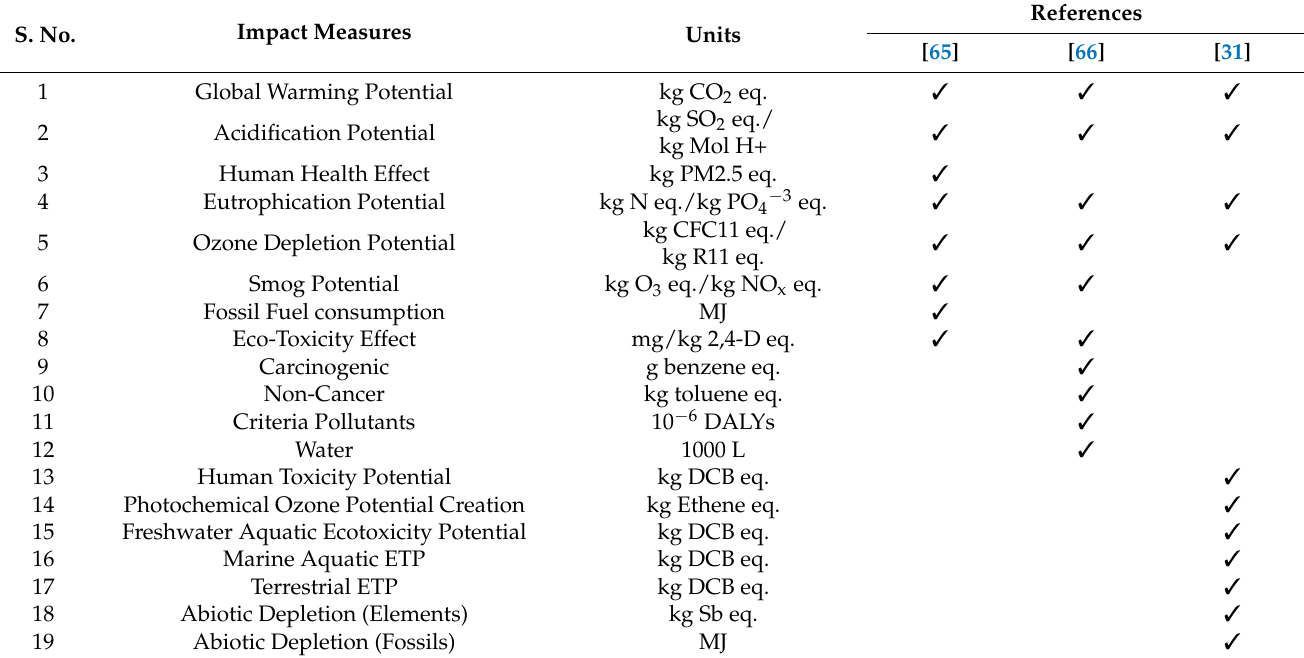
Table 4. List of impact measures considered in